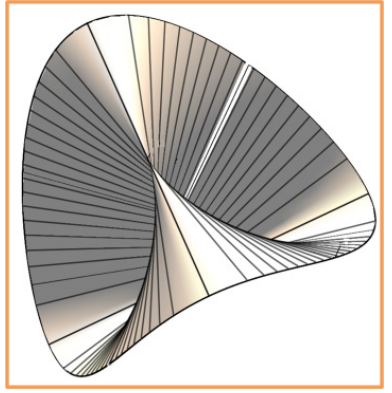
Figure 8. The two − subsystem cylindroid.